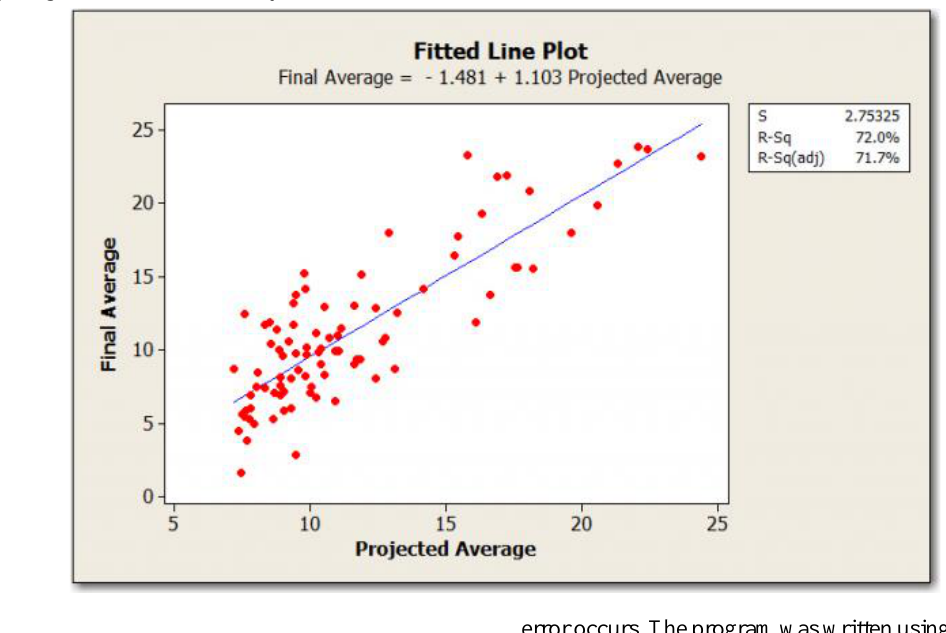
Figure 7. Sample regression with 12 hidden layer